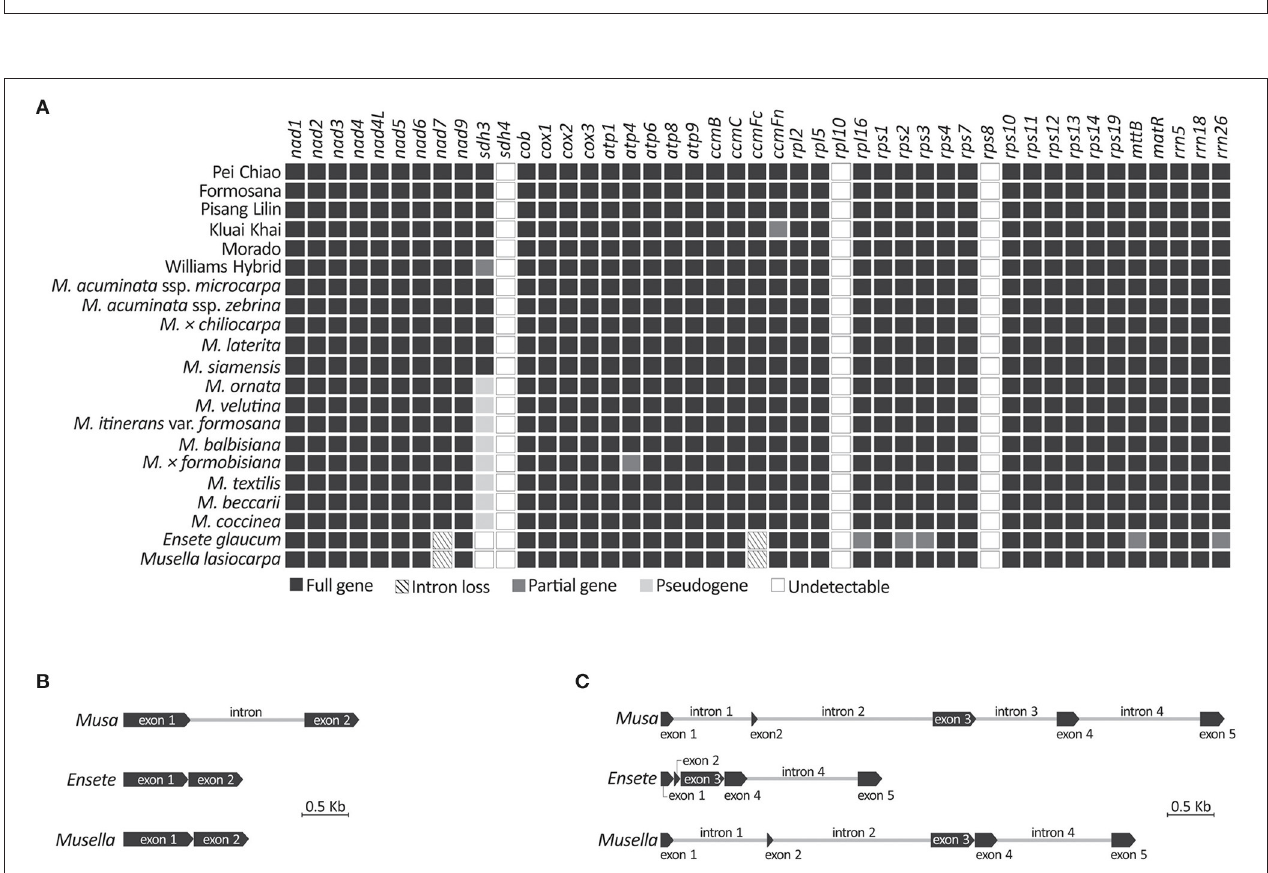
FIGURE 4 | Comparisons of mitochondrial genes recovered from genome skimming. (A) Presence or absence of mitochondrial genes in the sampled banana genome assemblies. (B) Intron loss from ccmFc . (C) Intron loss from nad7 .